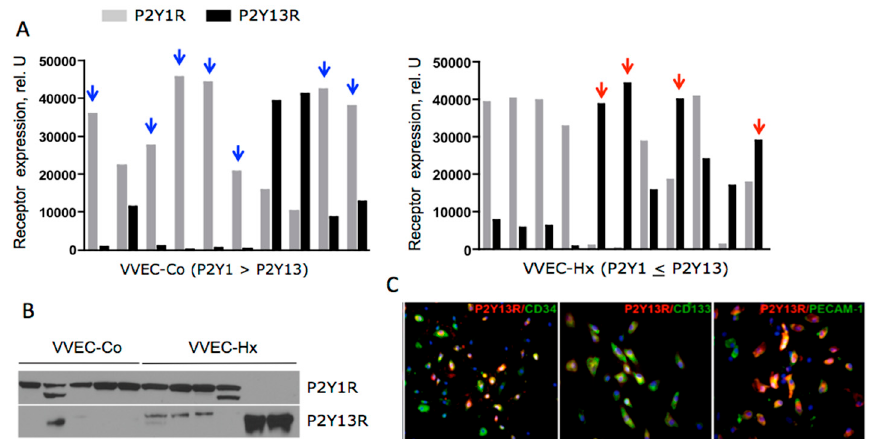
Figure 3. P2Y1 and P2Y13 receptor expression in pulmonary artery vasa vasorum endothelial cells (VVECs). Cells were isolated from the pulmonary arteries of control and chronically hypoxic hypertensive calves. ( A , B ): WB analysis of P2Y1R and P2Y13R expression in VVEC-Co and VVEC-Hx. Blue arrows indicate increased expression of P2Y1R compared to P2Y13R in some VVEC-Co populations; red arrows indicate increased expression of P2Y13 compared to P2Y1R in some VVEC-Hx populations; ( C ): Immunofluorescent analysis of P2Y13 (red) co-expression with CD31/PECAM, CD34, and CD133 (green) in VVEC-Hx.